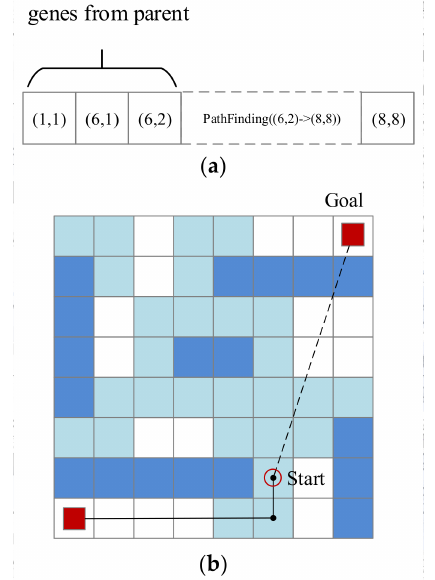
Figure 19. Path mutation. ( a ) Chromosome; ( b ) mutation operation on